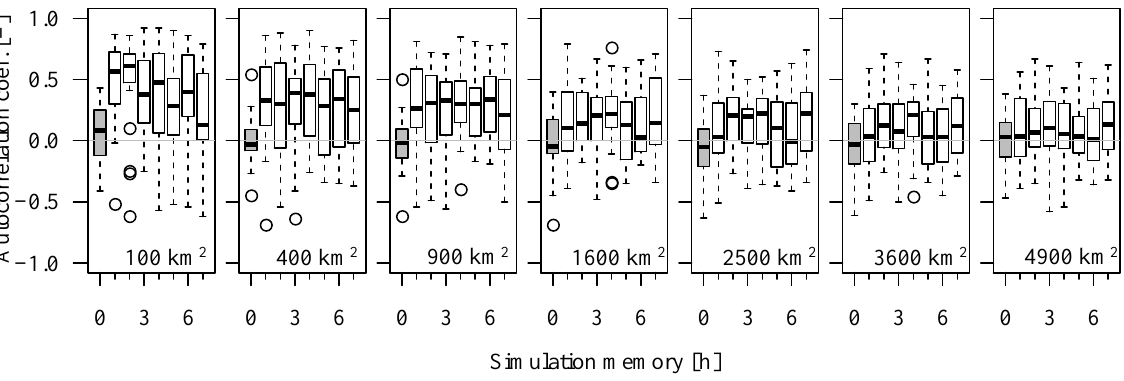
Fig. 16. Sensitivity analysis. Boxplots of the first-order autocorrelation coefficients (24 realisations) for the time series of the catchment’s areal precipitation for different catchment sizes and simulation memories (time-independent univariate simulation in grey, time-dependent multivariate simulations in blank), rainfall scenario with an advection speed of 6kmh − 1 and duration of 18h (see Fig. 5).